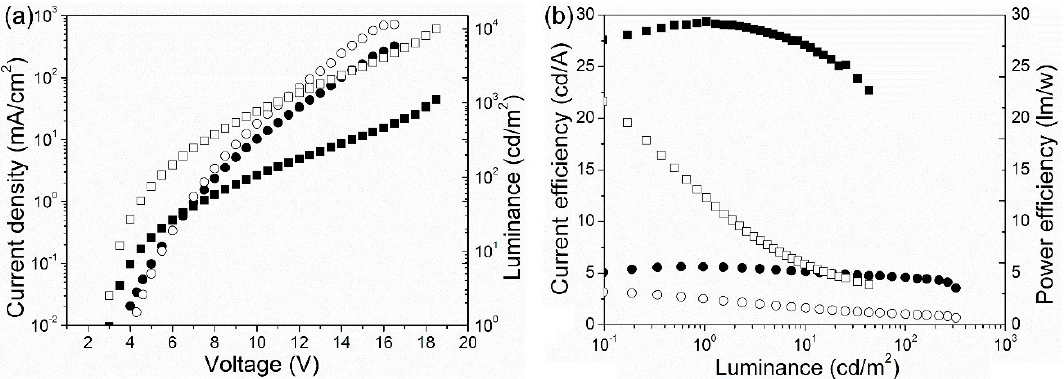
Figure 3. ( a ) J–V curves (solid symbols) together with L–V curves (open symbols). ( b ) Current efficiency (CE) versus luminance (solid symbols), and power efficiency (PE) versus luminance (open symbols) for devices A and B. Squares show device A and circles show device B.